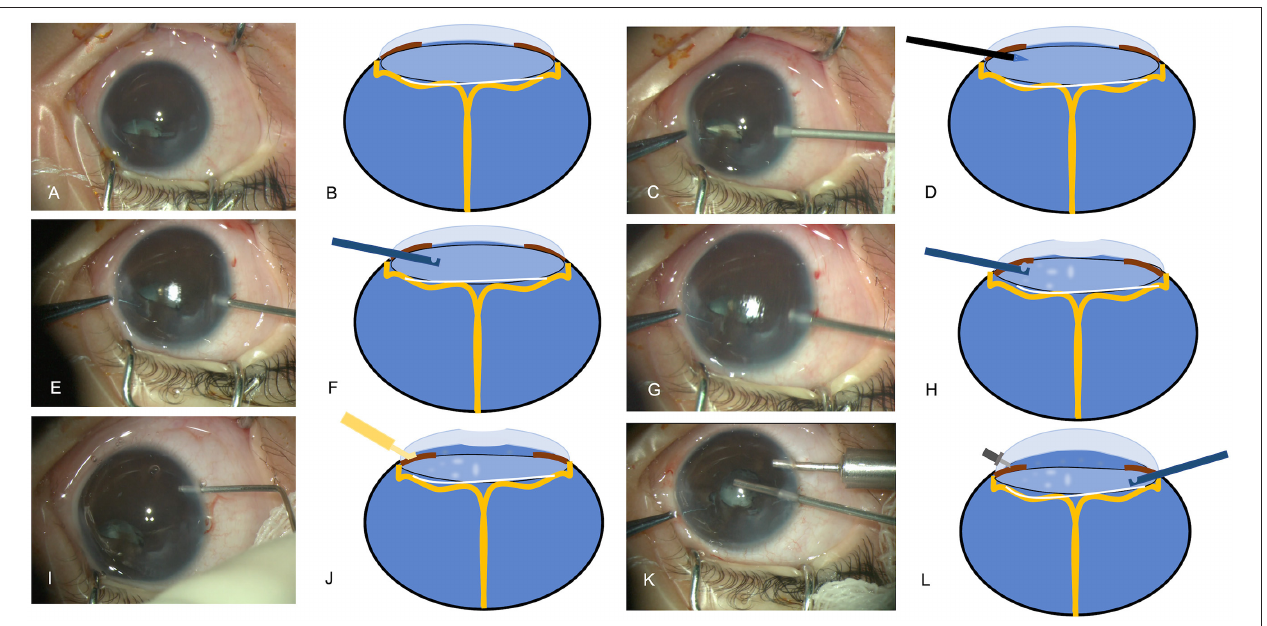
FIGURE 1 | The surgical procedures of dry-lensectomy. (A,C,E,G,I,K) Images acquired during the surgery, (B,D,F,H,J,L) schematic diagrams of the procedures. (A,B) A combination of anterior segment anomalies (anterior lens displacement, marked flat anterior chamber (AC), iridocapsular adhesions, capsule-endothelial adhesion with corneal opacification) was noted; (C,D) a limbal incision was made by 20-Gauge MVR blade in a slightly downward manner, starting from the limbus, going through the mid-periphery of the iris and then into the middle of dislocated lens; (E,F) the 23-Gauge vitrector went through the same approach into the lens without anterior chamber irrigation and with cutter off; (G,H) as the vitrector is in the lens, the vitrector started to do the cutting with suction; (I,J) the viscoelastic can be easily injected into the AC to reconstruct the AC; (K,L) the AC maintainer was inserted followed by the lensectomy in a traditional